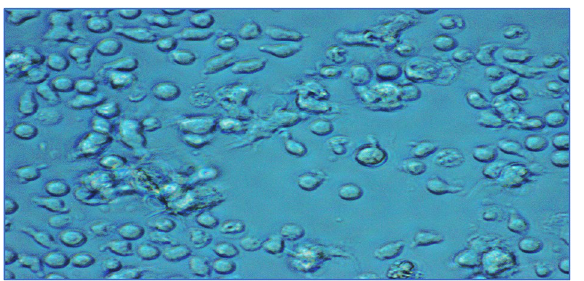
Figure 4. Light microscope (20X) image of the cellular uptake of Nile Tilapia fish scale-based collagen nanoparticles by peripheral blood mononuclear cells (PBMCs), showing cells with filopodia and lamellipodium.